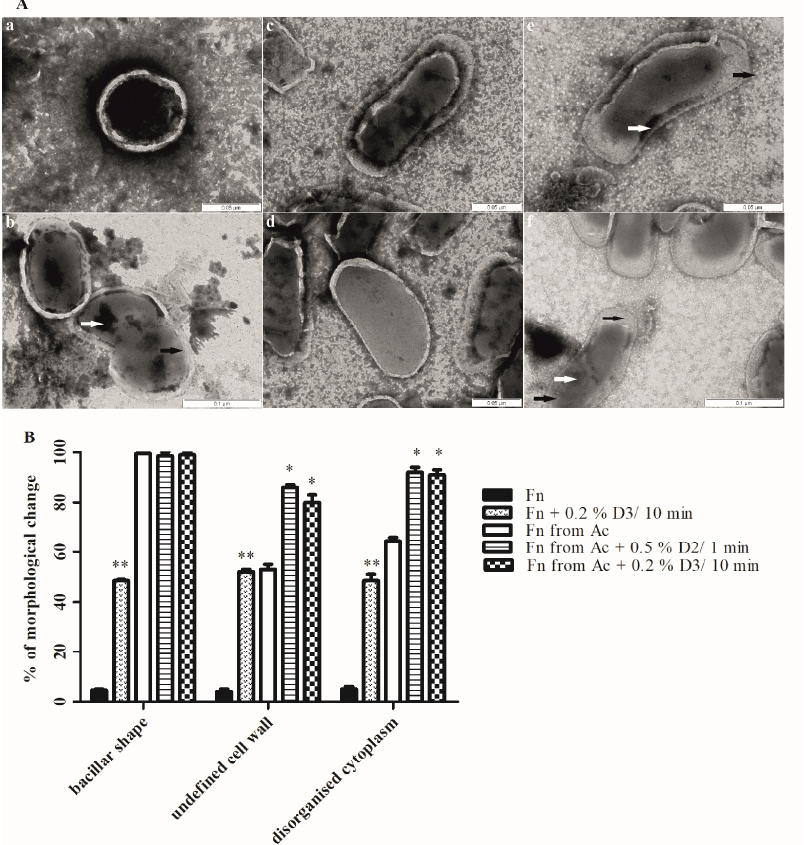
Figure 5. ( A ): TEM images of F. novicida ( a ), F. novicida treated with 0.2% D3 for 10 min ( b ), F. novicida after growth within A. castellanii ( c , d ), F. novicida after growth within A. castellanii treated with 0.2% D3 for 10 min ( e ), F. novicida after growth within A. castellanii treated with 0.5% D2 for 1 min ( f ). The bacteria were prepared for TEM by negative staining. The cell morphology was observed on samples in which around 50% of the bacteria were destroyed by disinfectants. Untreated amoeba-grown and agar-grown bacteria cells were used as control. The ten fields for each sample were randomly photographed. The thick black arrows show an undefined cell wall, the thick white arrows show clumping of the chromatin, thin black arrow shows separation of the cytoplasm from the cell wall. ( B ): Quantitative analyses of the morphological changes and membrane integrity of F. novicida (Fn) and F. novicida grown in amoeba (Fn from Ac) after treatment with disinfectants. Morphological changes were determined by electron microscopy counting at least 100 bacteria for each sample and using following criteria: (a) bacillar shape, (b) undefined cell wall, (c) disorganised cytoplasm. Student t -test, * p < 0.05, ** p < 0.001 were accepted as significantly different from control sample.